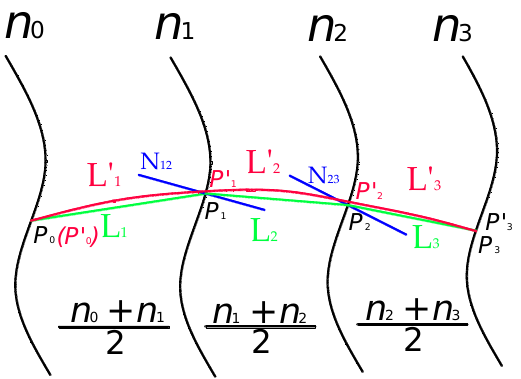
Figure 2. Schematic diagram of ray tracing in gradient index media.